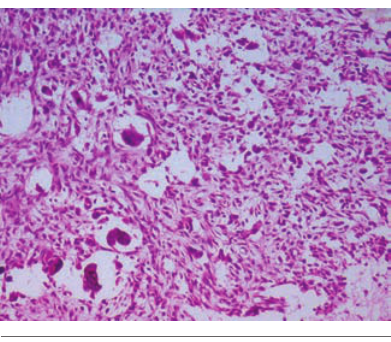
Figure 6. Photomicrograph showing tumor mass comprised of proliferation of spindle cells with irregular osteoid, rimmed by osteoblasts (Haematoxylin and Eosin, 400 ¥ magnification).